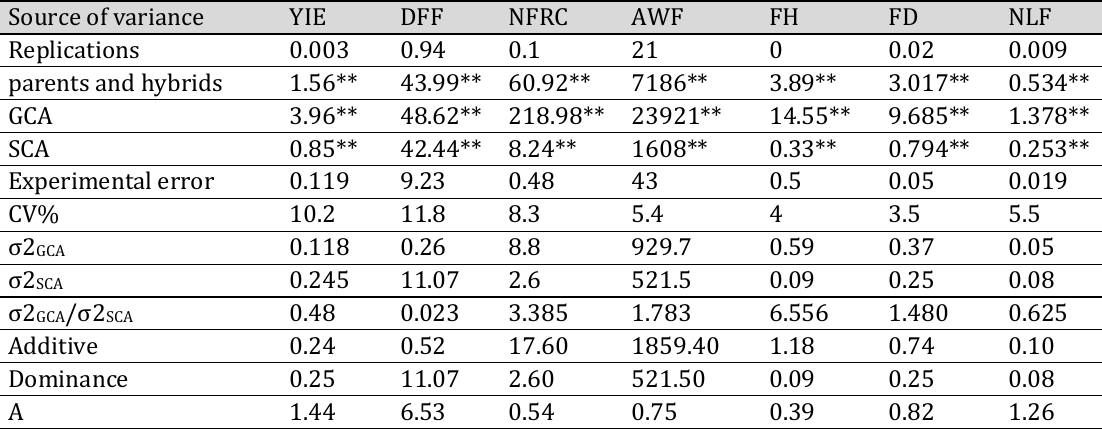
Table 2. Analysis of variance for the lines and hybrids and the components of variance for the traits: single plant yield, fruit weight, fruit height, fruit diameter, number of locales per